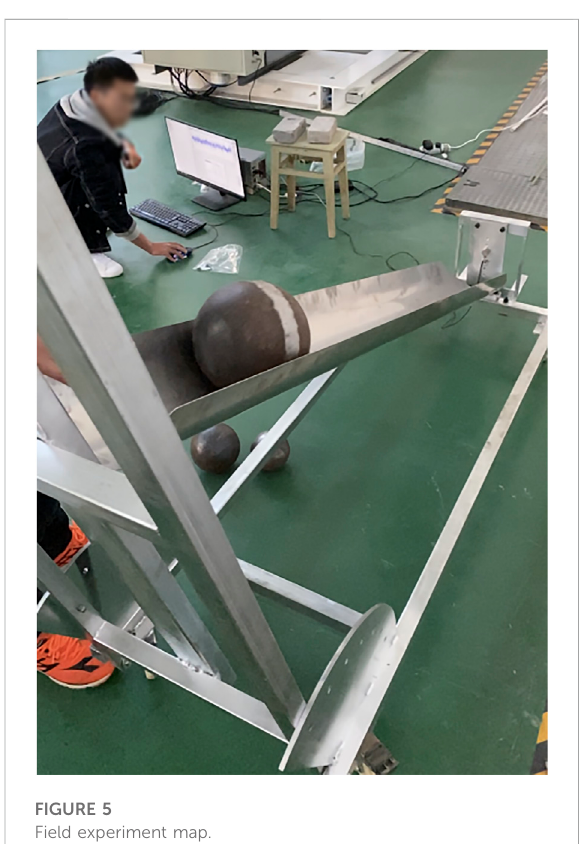
FIGURE 5 Field experiment